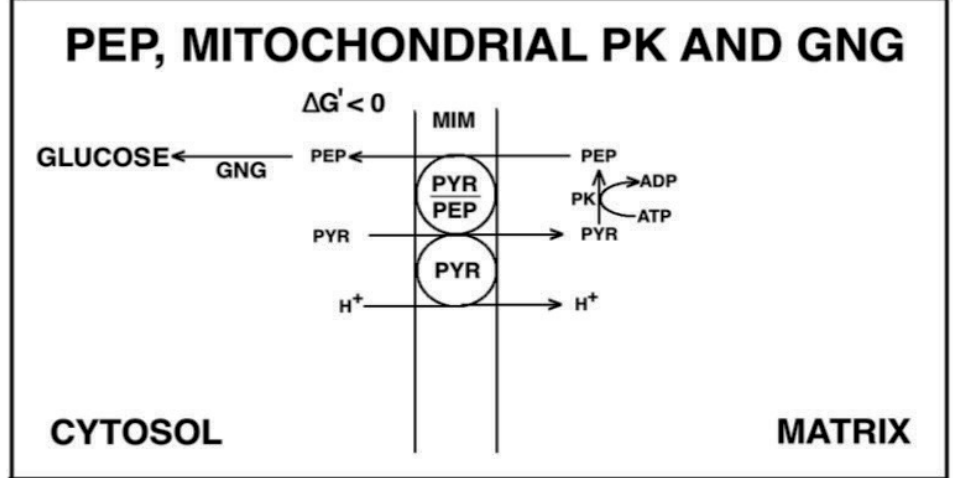
Figure 10. The role of the mitochondrial pyruvate kinase in gluconeogenesis in rat kidney. The following scenario is proposed: pyruvate (PYR) derived from L-lactate and amino-acids enters mitochondria via its own carrier; once inside the matrix via the mitochondrial pyruvate kinase (PK) phosphoenolpyruvate (PEP) is synthesized, the reaction being made possible by the removal of the newly synthesized PEP which is exported in exchange with PYR via the putative PYR/PEP